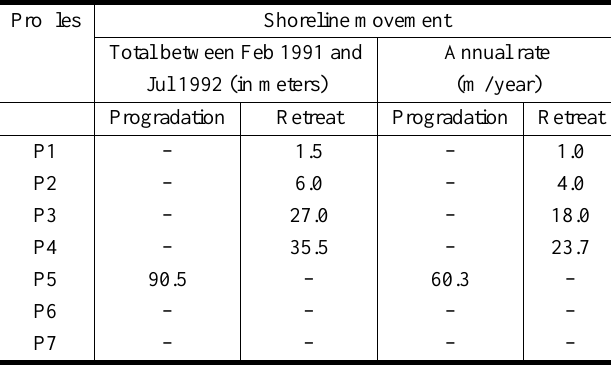
Totalmovementofthecoastline, inmeters, atprofiles1, 2, 3, 4,